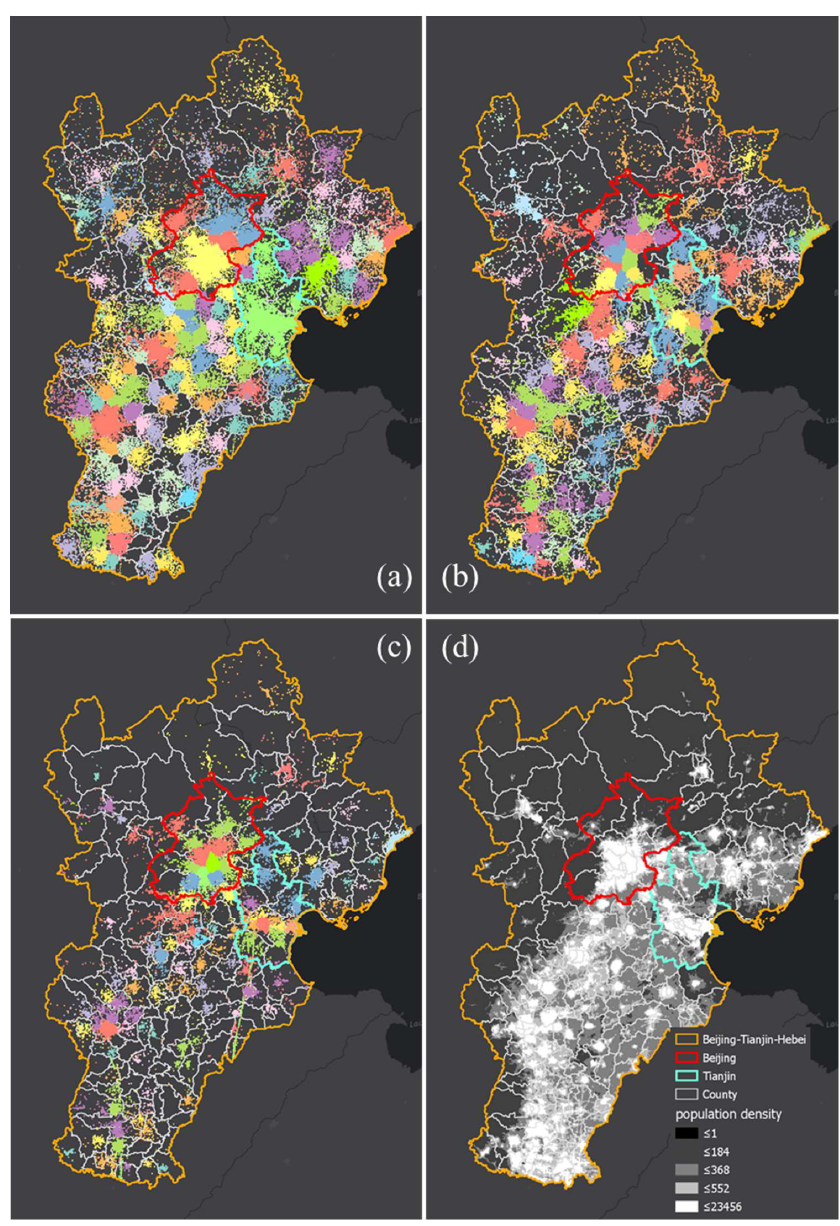
Figure 7. Communities detected with Louvain using ( a ) 100% ( b ) top 10.8% ( c ) top 5.3% of the cellphone call flow data. ( d ) Population density visualized with quantile classification of the same Beijing-Tianjin-Hebei (BTH) region.